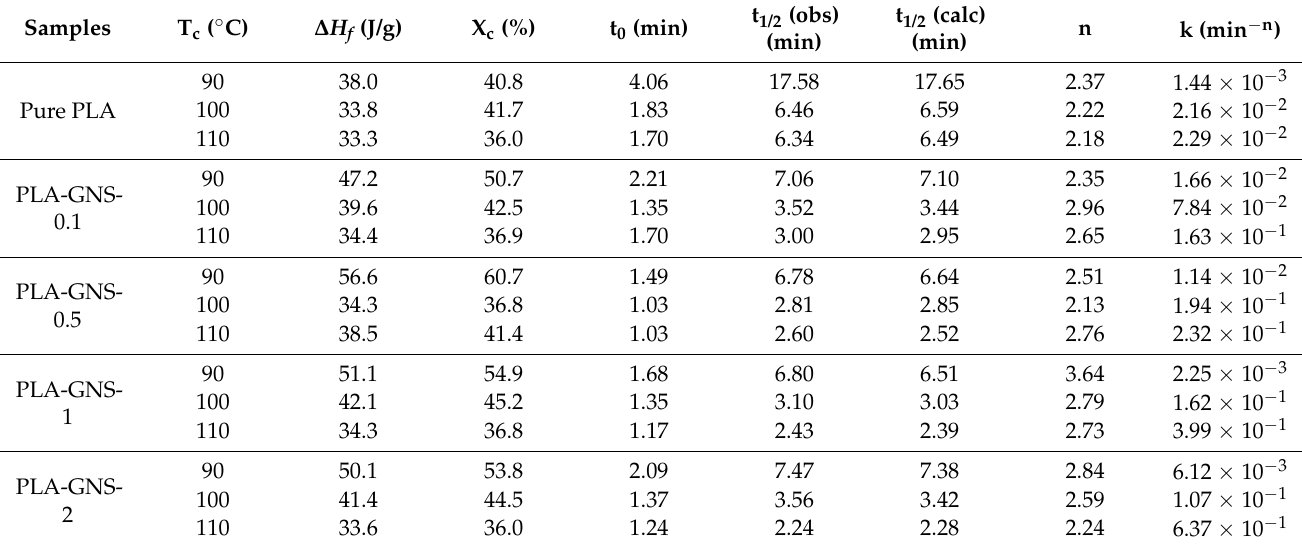
Table 1. Collated values of heat of fusion ( ∆ H f ), degree of crystallinity (X c ), induction time (t 0 ), and half time of crystal- lization (t 1/2 ) and Avrami parameters for pure PLA and PLA-GNS nanocomposites at different isothermal crystallization temperatures, T c